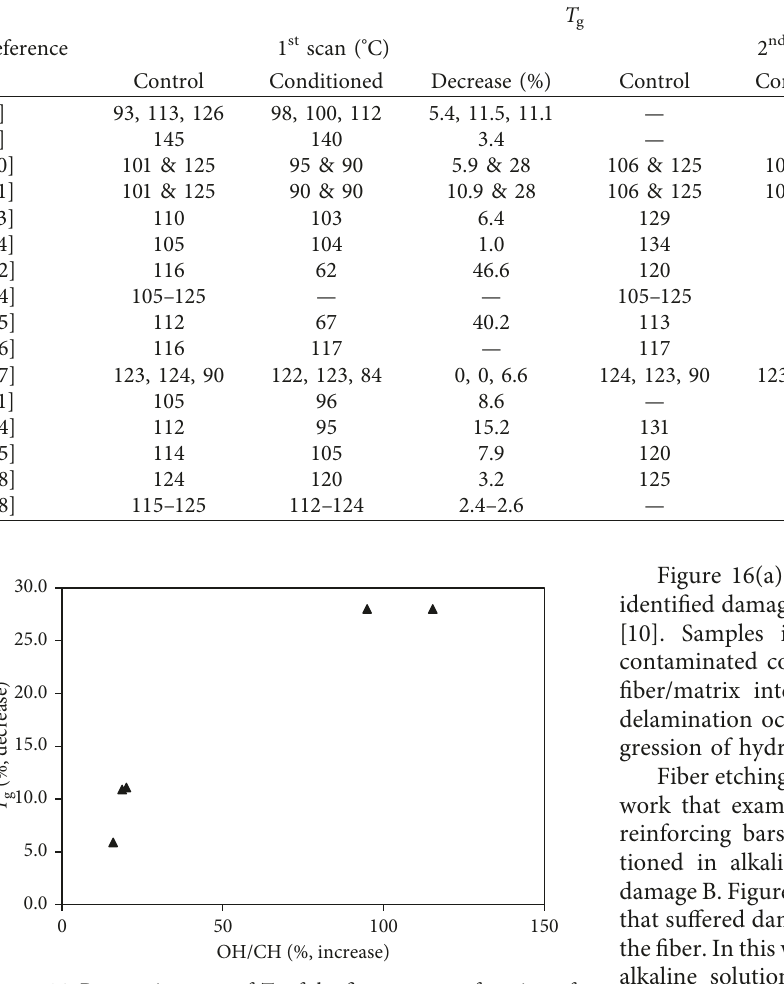
Figure 14: Percent increase of T g of the first scan as a function of percent increase of OH/CH after conditioning of epoxy-GFRP